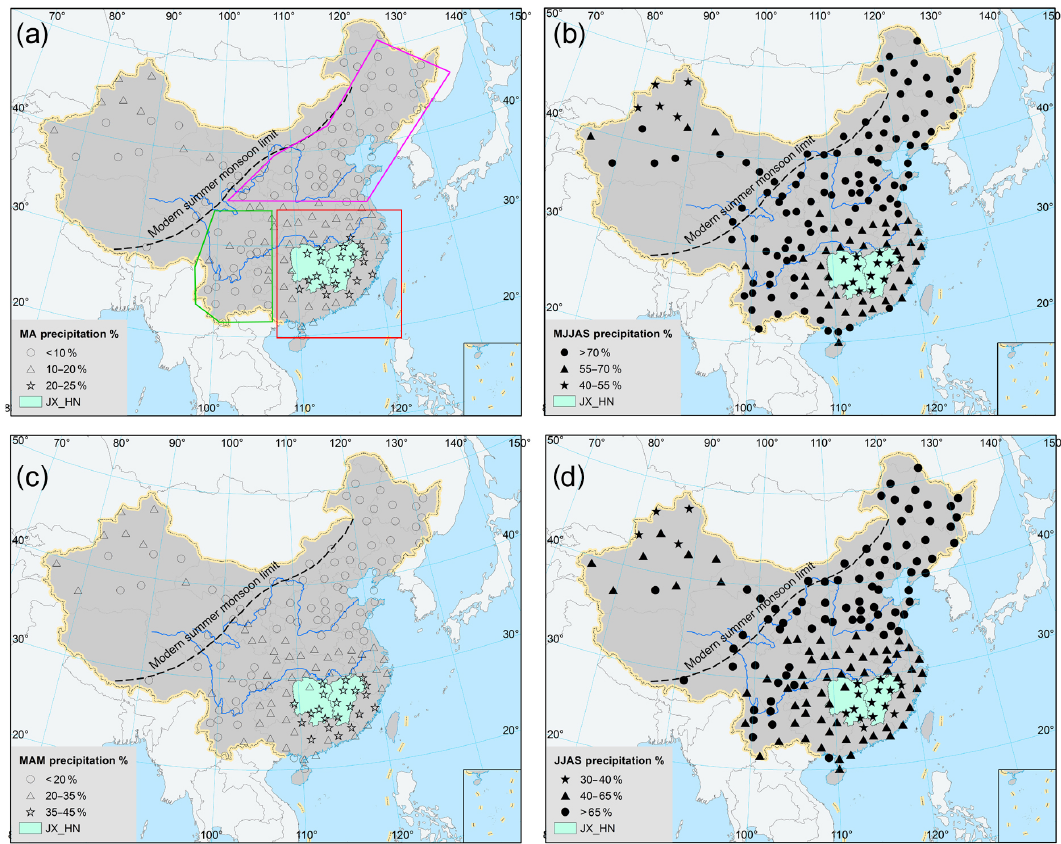
Figure 2. The percentage of spring ( a , March to April) and EASM ( b , May to September) precipitation amount relative to the annual precipitation amount in the study area. Panels (c) and (d) are similar to (a) and (b) , except that spring precipitation is shown from March to May in (c) and EASM precipitation between June and September in (d) . The Jiangxi and Hunan provinces (JX_HN) are highlighted in jade color. The monthly precipitation data (1951–2014) from 11 meteorological stations (Jiujiang, Guixi, Nanchang, Guangchang, Ji’an, Ganzhou, Changsha, Yueyang, Hengyang, Chenzhou, Xinning) in Jiangxi Province and the eastern Hunan Province were used to examine the relationship between ocean-atmospheric circulation, precipitation amount, and δ 18 O in the SPR region. The red, pink, and green polygons in panel (a) indicate southeastern, northern, and southwestern regions of the MRC,